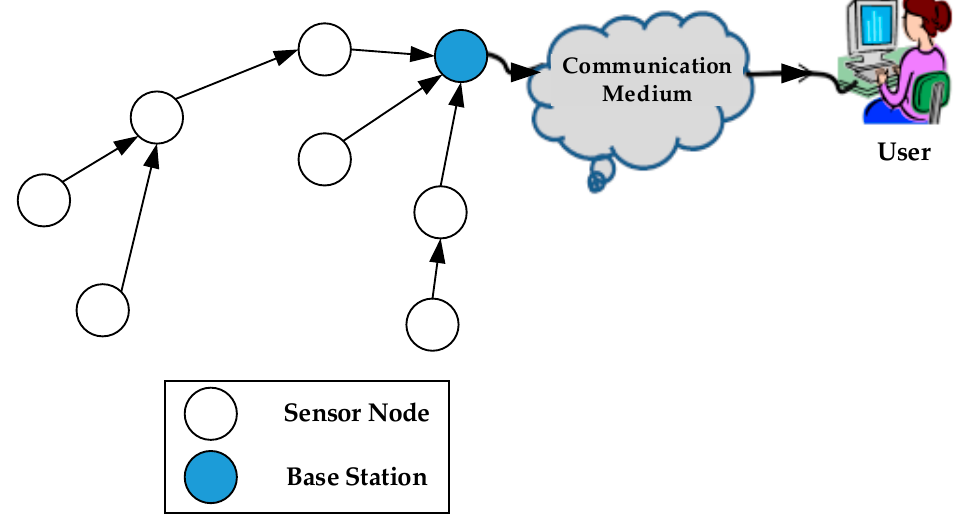
Figure 7. An illustration of a data flow in WSN.